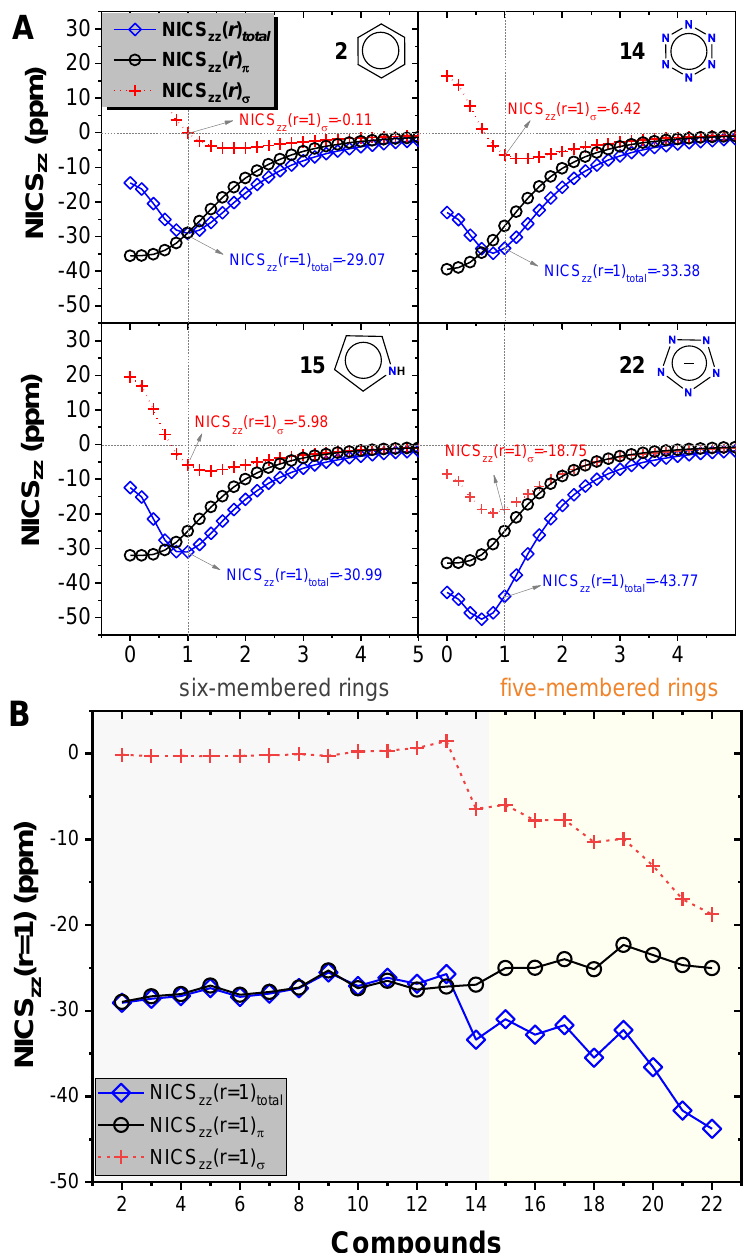
Figure 2. (A) NICS zz ( r ) total , NICS zz ( r ) π , and NICS zz ( r ) σ of 2 , 14 , 15 , and 22 as a function of r , the vertical distance relative to the ring critical point. (B) NICS zz ( r = 1) total , NICS zz ( r = 1) π , and NICS zz ( r = 1) σ of all 21 of the studied cyclic systems.